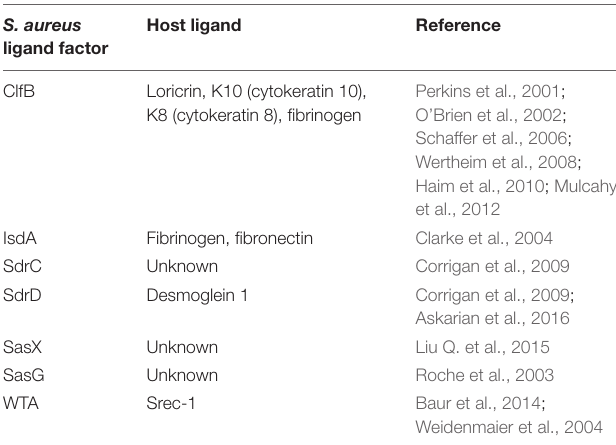
TABLE 1 | Major S. aureus -host